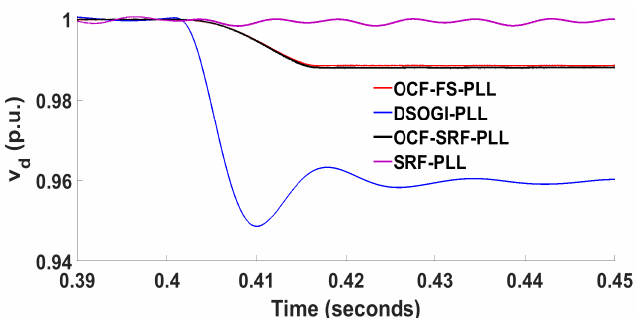
Figure 19. The grid position during grid voltage with frequency change.